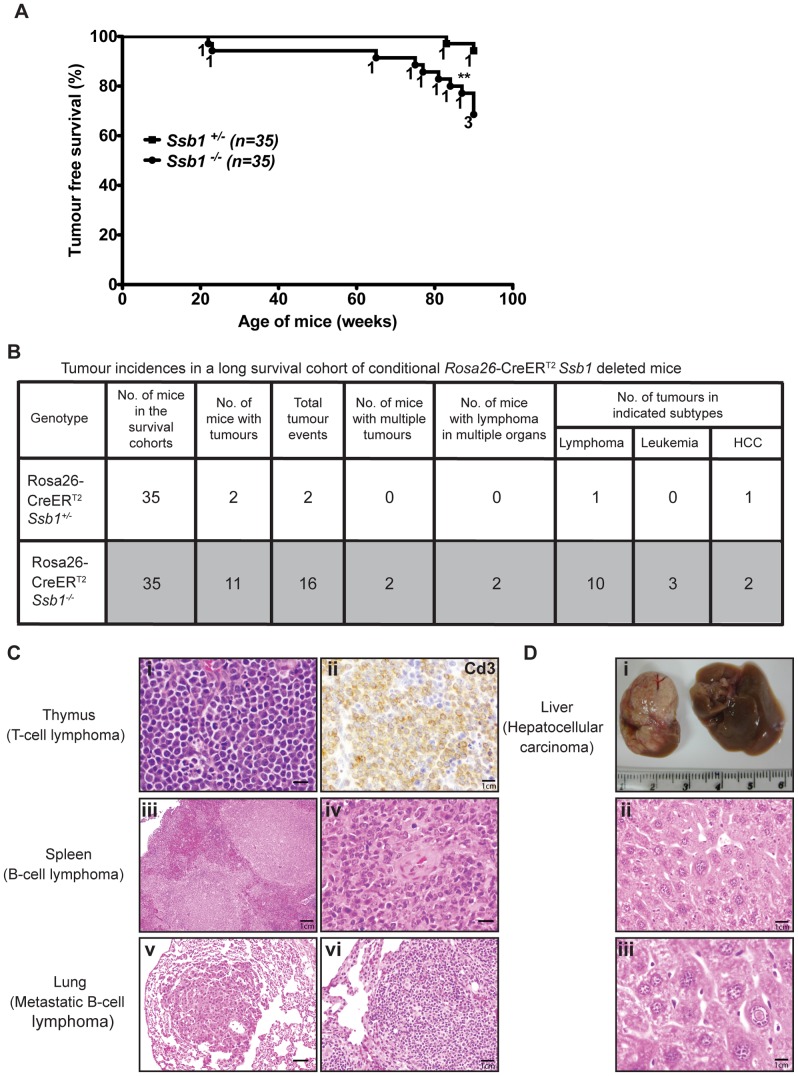
Broad tumour spectrum in conditional Ssb1-deleted Rosa26-CreERT2: Ssb1
−/− mice.(A) Long time survival cohort of Rosa26-CreERT2: Ssb1
+/− (n = 35) and Rosa26-CreERT2: Ssb1
−/− (n = 35) mice were monitored for 86 weeks after Ssb1 deletion for tumour development. (A) Kaplan-Meier survival analysis showed tumour free survival rate of indicated genotypes over 90 weeks (**P<0.01). (B) Tumour incidence and a spectrum in Rosa26-CreERT2: Ssb1
−/− mice compared with Rosa26-CreERT2: Ssb1
+/− mice. (C) Representative sections have T lymphoma in thymus (top panel) and B lymphomas in spleen (middle panel), which spread to lung in a Rosa26-CreERT2: Ssb1
−/− mice (bottom panel). Representative images of Haematoxylin and eosin stained sections of tumours in indicated organs are shown. Immunohistochemical staining of Cd3 (top panel, right) confirmed T-cell lymphoma in thymus (Scale bars, i = 40 µm, ii = 120 µm, iii = 20 µm, iv = 40 µm, v = 60 µm, vi = 80 µm). (D) Representative image of liver cancer (hepatocellular carcinoma, HCC) in a Rosa26-CreERT2: Ssb1
−/− mouse. Representative images of tumour mass (upper panel) and Haematoxylin and eosin-stained liver section (middle and lower panels) are shown (Scale bars, ii = 100 µm, iii = 140 µm).